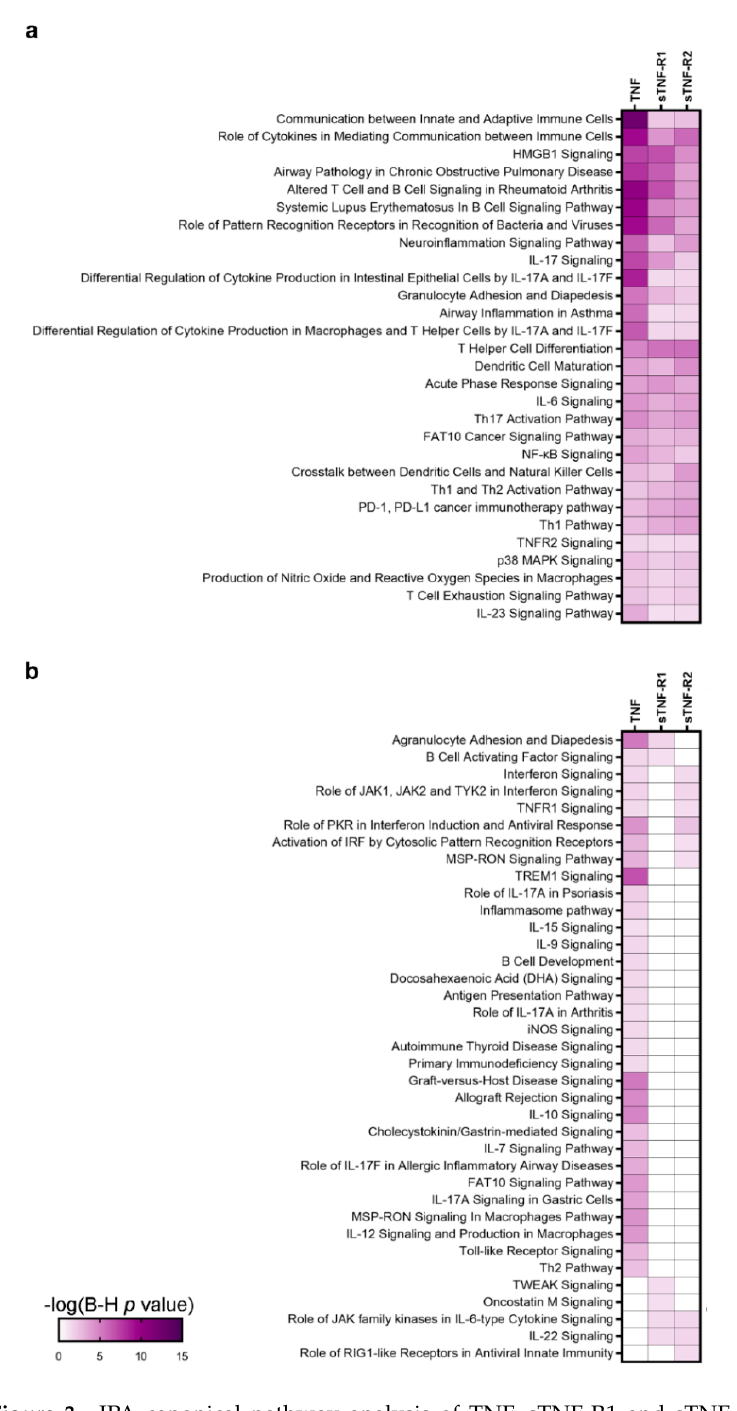
Figure 3. IPA canonical pathway analysis of TNF, sTNF-R1 and sTNF-R2 molecular patterns. ( a ) Heatmap of CPs shared among the three profiles pinpointed, in general, a stronger association between inflammatory pathways and TNF profile, as compared to sTNF-R1 and sTNF-R2 profiles. Communication between innate and adaptive immune cells, altered T cell and B cell signalling in rheumatoid arthritis and systemic lupus erythematosus in B cell signalling pathway showed lower p -value in the TNF molecular pattern. HMGB1 signalling, and IL-17 signalling were annotated to a similar extent in TNF and sTNF-R1 profiles. The role of cytokines in mediating communication between immune cells, T helper cell differentiation and dendritic cell maturation were the most significant CPs which characterised the sTNF-R2 profile. Other CPs (including acute phase response signalling, IL-6 signalling, Th17 activation pathway, Th1 and Th2 activation pathway, PD-1,